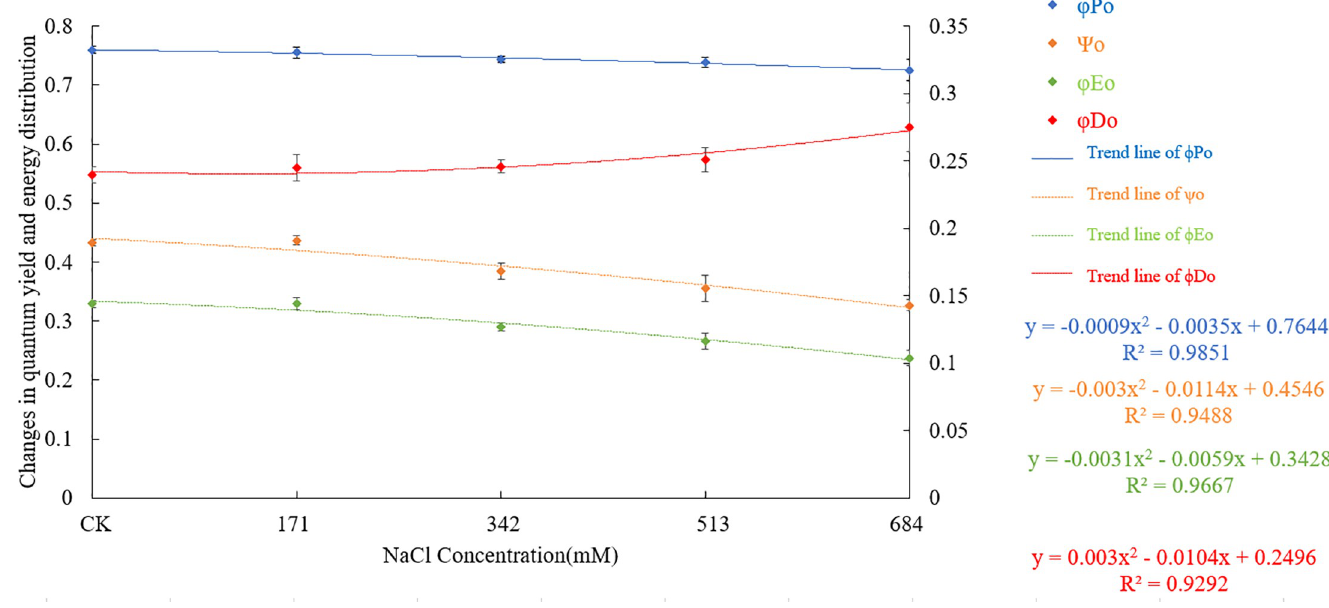
Fig 11. Changes of chlorophyll a fluorescence parameters under salt stress of Salix alba L.